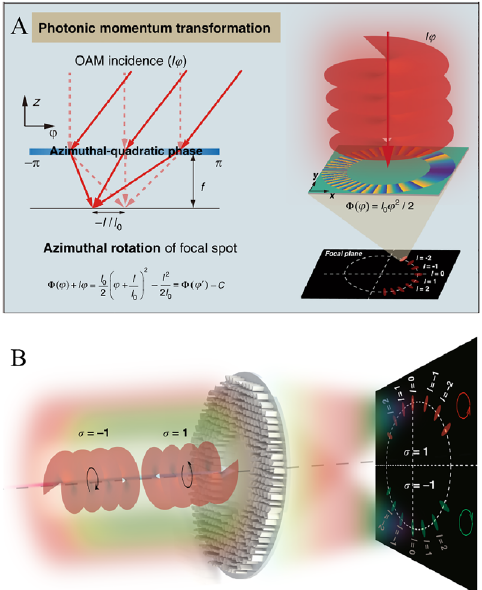
Figure 10: Applications of azimuthal-quadratic metalenses for detection of photonic angular